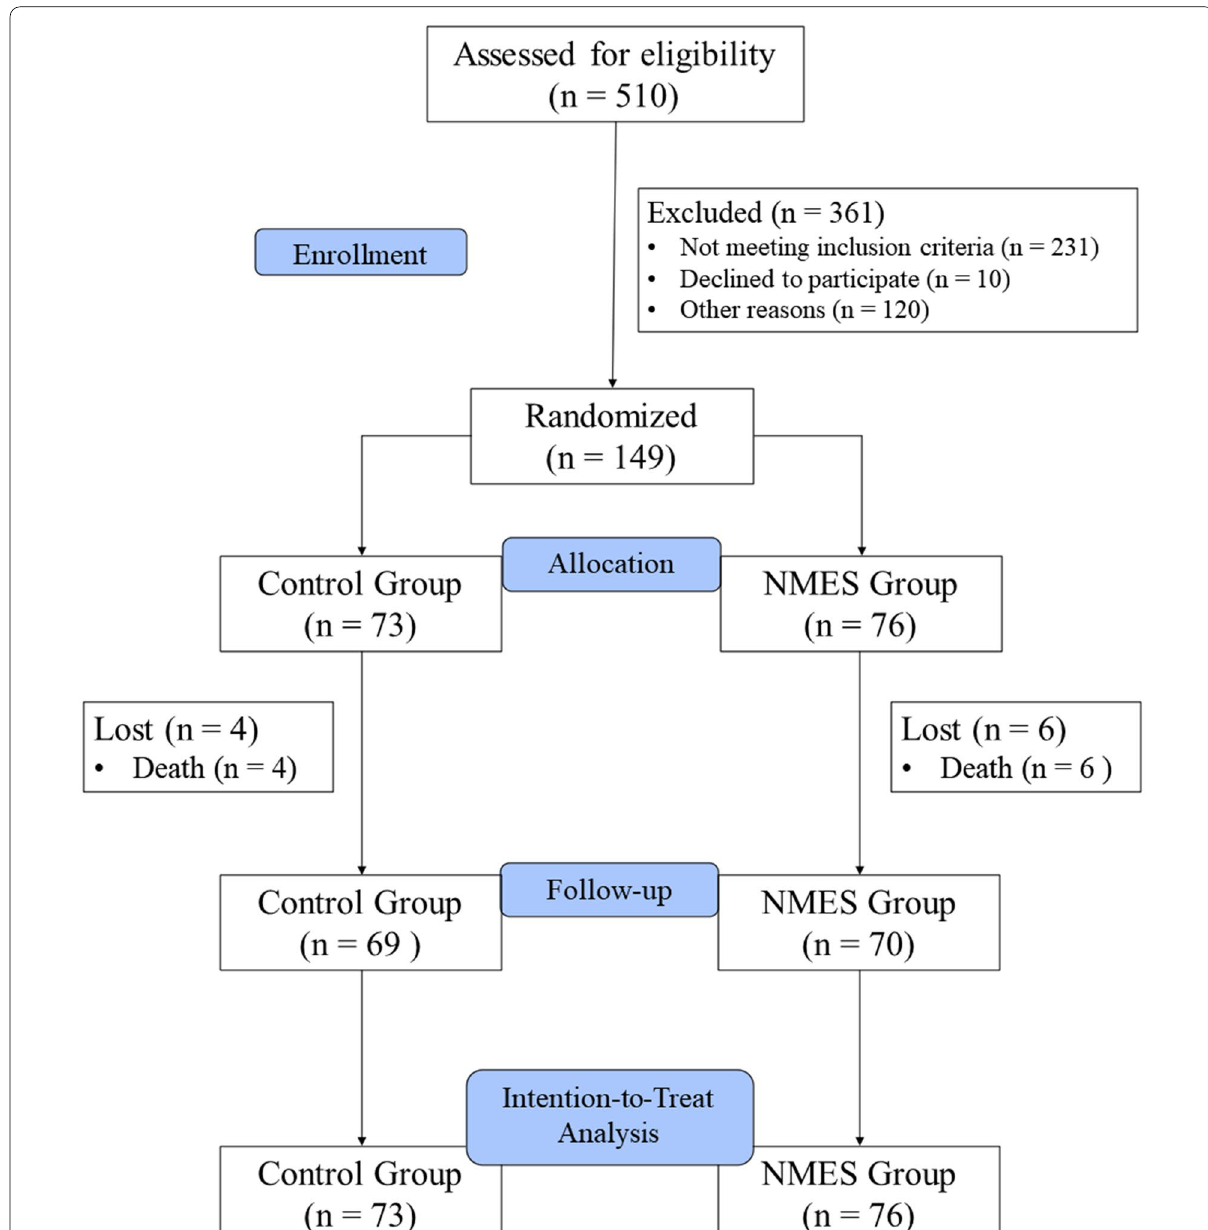
Fig. 4 Flow diagram. Other reasons: death before randomization, inter‑hospital transfers, not being able to sign the consent form within 48 h, and discharge before